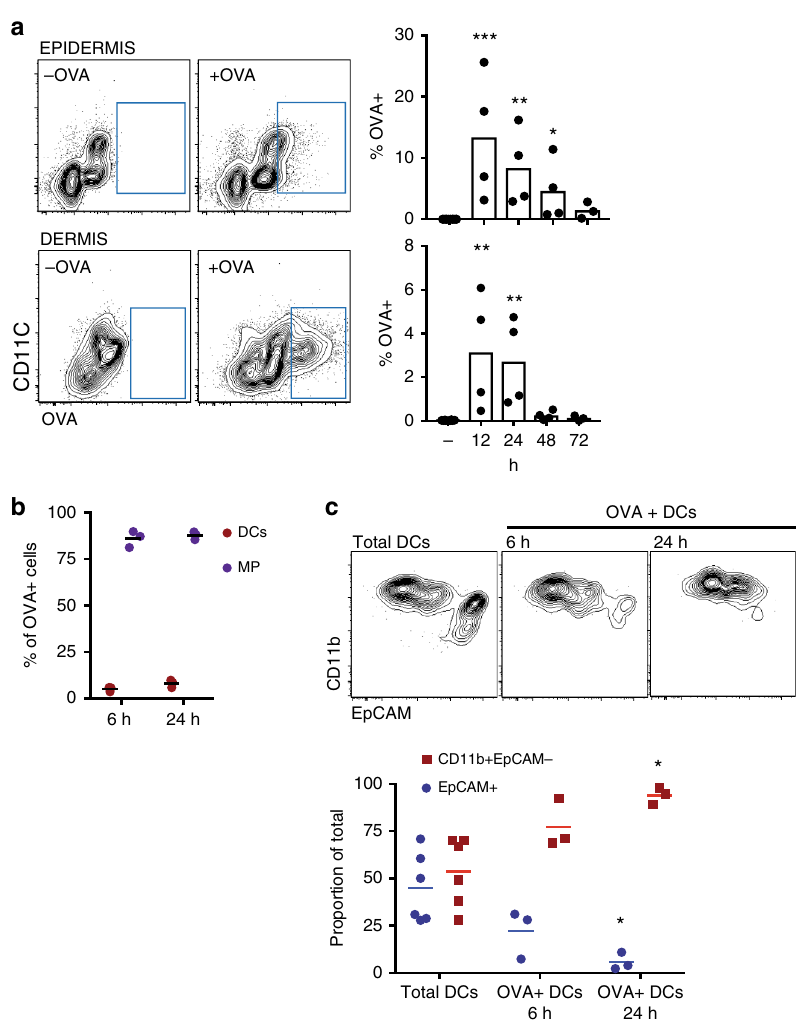
Fig. 1 Phenotype of CD11c + MCHII + cells that are taking up OVA in the skin. a Representative plots of OVA + cells in the epidermis and dermis of Balb/c mice 24 h after applying OVA AF647 and percentage of OVA + cells in dermis and epidermis in CD11c + MHCII + cells ( N = 3 – 4 mice/group). – indicates control mice in which no patch was placed. * p < 0.05, ** p < 0.01, *** p < 0.001 vs no antigen. Kruskal-Wallis test with Dunn ’ s multiple comparison. b Relative proportion of DCs (red) and macrophages (blue) of all OVA + cells in the dermis (3 mice/group). c Expression of CD11b and EpCAM among total DCs or OVA + DCs in the dermis. The top shows representative staining, while the bottom shows a summary of at least three mice/group. Circles represent EpCAM + DCs and squares represent CD11b + EpCAM − . * p < 0.05 vs. frequency in Total DCs. Kruskal – Wallis test with Dunn ’ s